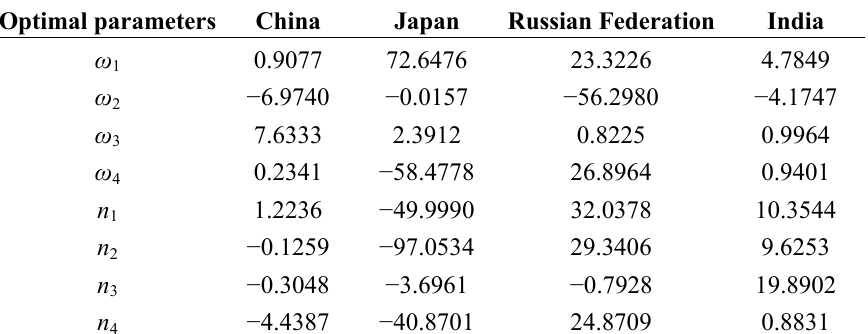
and n for four i i